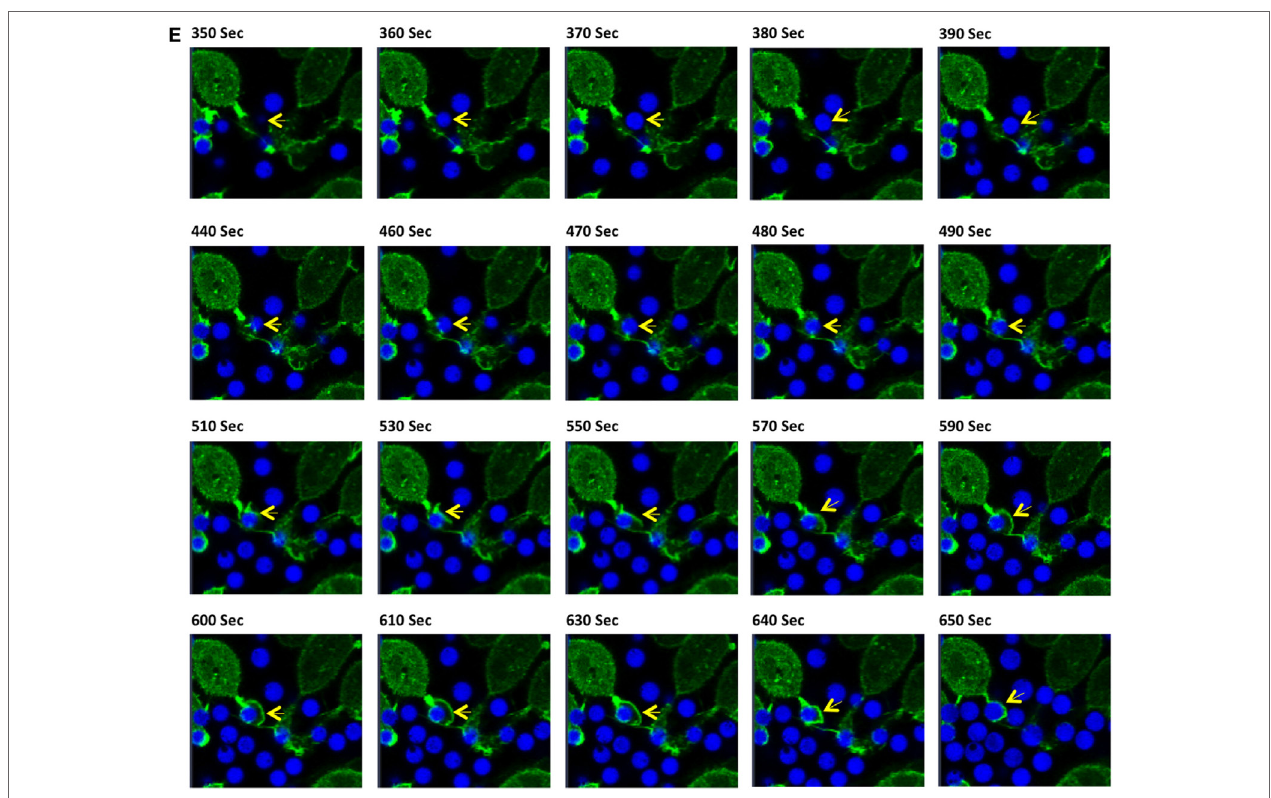
FigUre 6 | Live-cell imaging of IpLITR 1.1b-mediated target interactions at different incubation temperatures. Rat basophilic leukemia-2H3 cells (3 × 10 5 ) stably co-expressing IpLITR 1.1b and LifeAct-GFP were incubated at 37°C (a,B) or at 27°C (c–e) with 9 × 10 5 α HA monoclonal antibody-coated 4.5 µm bright blue microspheres. Immediately after the addition of target beads, images were collected at 10 s intervals for ~8 min using a Zeiss LSM 710 laser scanning confocal microscope (objective 60 × , 1.3 oil plan-Apochromat; Munich, Germany). Representative time-stamps in (a,B) were extracted from Videos S12 in Presentation 2 and S15 in Presentation 3 of Supplementary Material, respectively, and the time-stamps in (c–e) were from Videos S16–S18 in Presentation 3 of Supplementary Material, respectively. In all time-stamps, target beads are indicated with an arrowhead and in (b; 130 s) a second cell with a pre-captured target bead is indicated with an